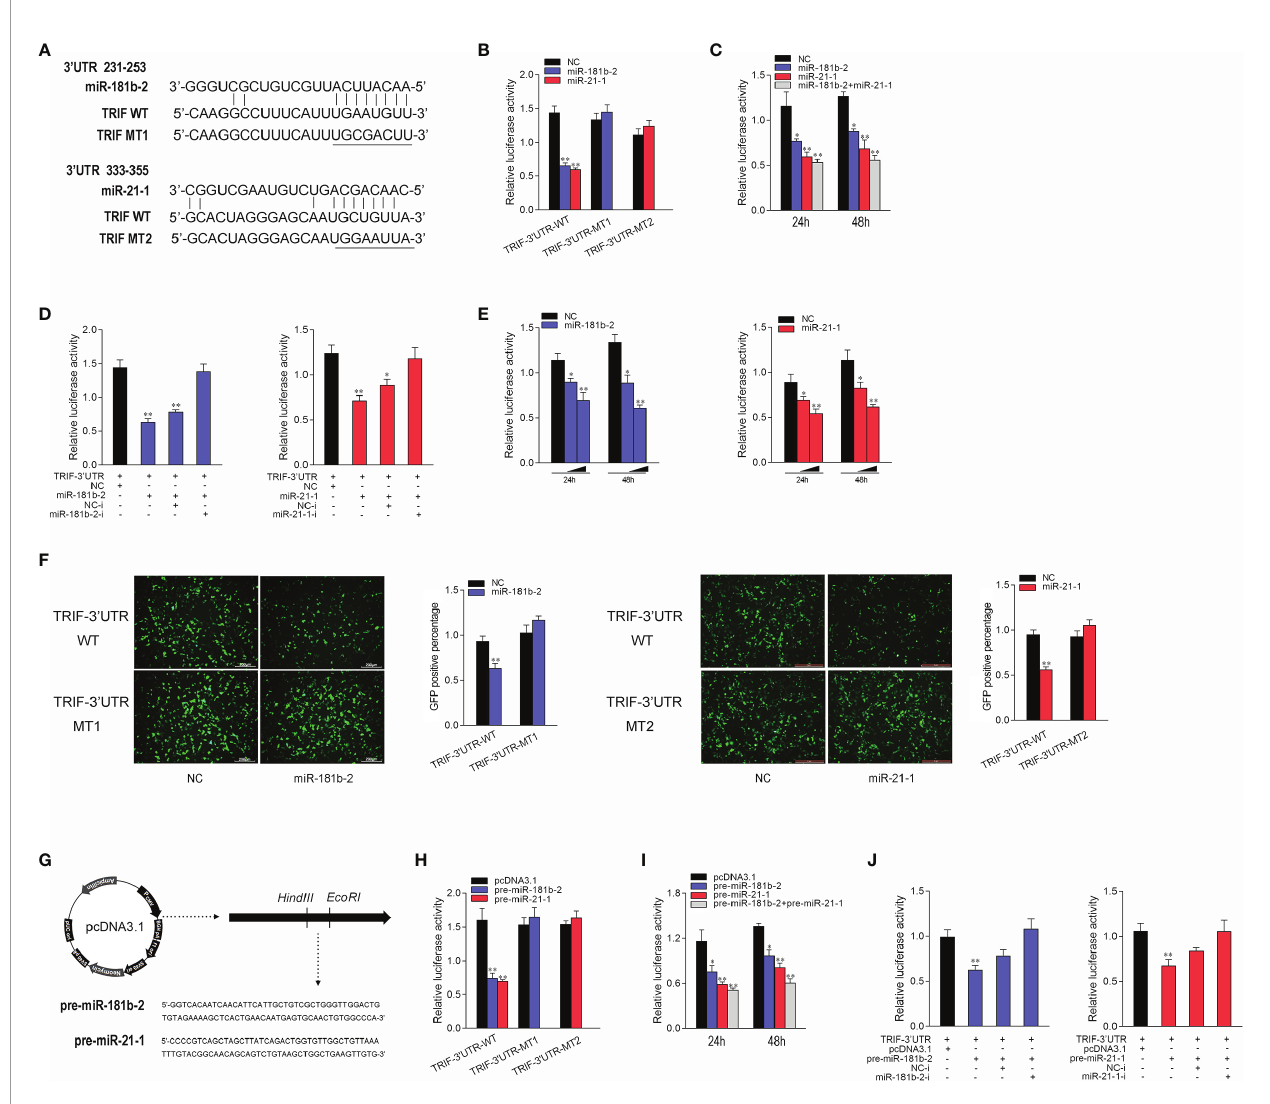
FIGURE 3 | Miiuy croaker TRIF is a directly target of miR-21-1 and miR-181b-2. (A) Sequence alignment of the 3 ’ UTR of TRIF and its binding sites. (B) TRIF- 3 ’ UTR-WT or TRIF-3 ’ UTR – MT1, TRIF-3 ’ UTR – MT2 was cotransfected with miR-21-1 or miR-181b-2 into HEK293 cells with NC as a negative control, and cells were harvested after 24 h to detect luciferase activity. (C) MiR-21-1 and miR-181b-2 was transfection with TRIF-3 ’ UTR into HEK293 cells, 24 h later, to detect and normalize luciferase activity to Renilla luciferase activity. (D) Cotransfect TRIF-3 ’ UTR with miR-21-1 or miR-181b-2 mimics or inhibitors into HEK293 cells, NC or NC inhibitors as negative control, and harvest cells 24 h later, to detect and normalize luciferase activity to Renilla luciferase activity. (E) TRIF-3 ’ UTR was cotransfected with miR-21-1 or miR-181b-2 into HEK293 cells, with NC as negative control, and concentration gradients and time gradients were set respectively. (F) The wild- type or mutant mVenus-TRIF-3 ’ UTR and miR-21-1 or miR-181b-2 were cotransfected into HEK293 cells. The right histogram is the percentage of GFP positive under excitation light. (G) Pre-miR-21-1 and pre-miR-181b-2 sequence was inserted into pcDNA3.1 vector using HindIII and EcoRI restriction sites to construct a pre-miR-21-1 or miR-181b-2 expression plasmid. (H) TRIF-3 ’ UTR-WT or TRIF-3 ’ UTR-MT1, TRIF-3 ’ UTR-MT2 was cotransfected with pre-miR-21-1 or pre-miR- 181b-2 plasmids into HEK293 cells with pcDNA3.1 as a negative control, and cells were harvested after 24 h to detect luciferase activity. (I) Pre-miR-21-1 and pre- miR-181b-2 was transfection with TRIF-3 ’ UTR into HEK293 cells, 24 h later, to detect and normalize luciferase activity to Renilla luciferase activity. (J) Cotransfect TRIF-3 ’ UTR with pre-miR-21-1 or pre-miR-181b-2 and miR-21-1 and miR-181b-2 inhibitors into HEK293 cells, pcDNA3.1 and NC inhibitors as negative control, and harvest cells 24 h later, to detect and normalize luciferase activity to Renilla luciferase activity. All data are presented as the means ± SE from three independent triplicate experiments. ** p < 0.01, * p < 0.05 versus the